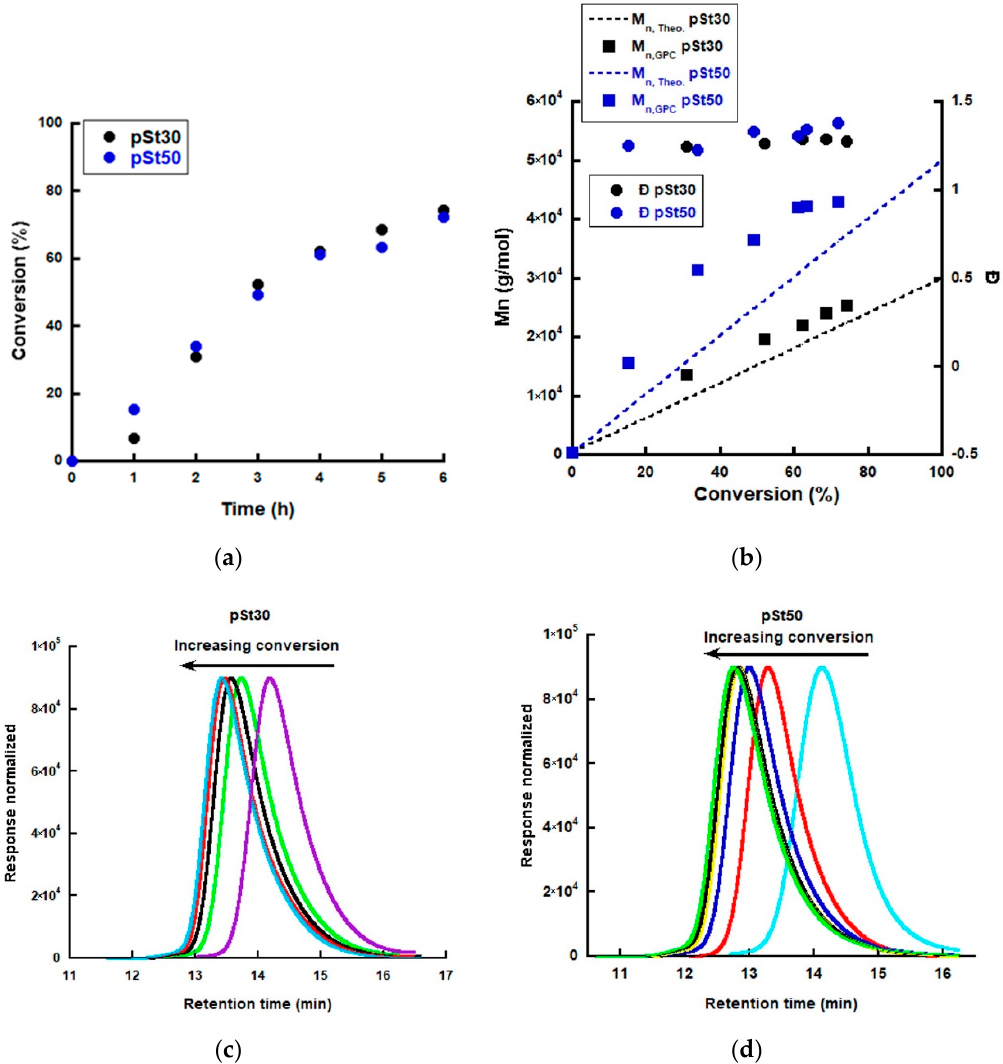
Figure 2. Miniemulsion polymerization of the polystyrene “A” block using RAFT Agent BM1430: ( a ) conversion versus time; ( b ) number average molecular weight and dispersity versus monomer conversion and molecular weight distributions of ( c ) polystyrene (pSt)30 and ( d ) pSt50 obtained by RI refractive index detector in GPC.